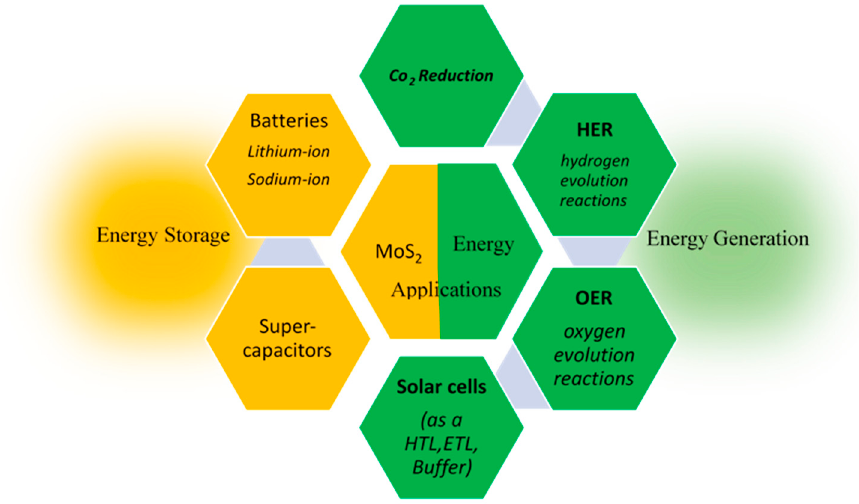
Figure 1. A schematic diagram for MoS 2 energy